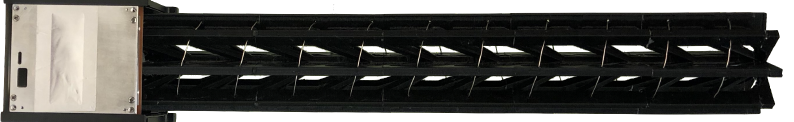
Figure 11. Prototype assembled in CubeSat